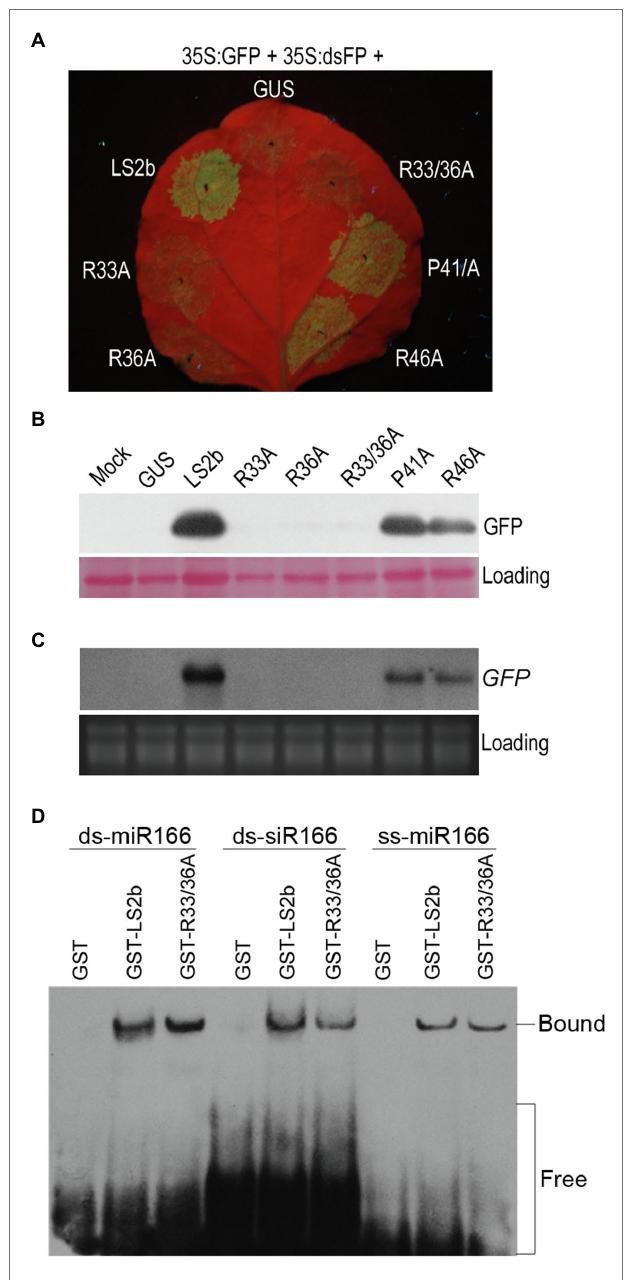
FIGURE 6 | Determination of suppressor activity and sRNA binding ability for LS2b mutants. (A) Observation of GFP fluorescence. The 6th true leaves of N. benthamiana plants were infiltrated with cells of Agrobacterium tumefaciens harboring 35S:GFP and 35S:dsFP, together with cells expressing GUS, LS2b or its mutants as indicated. The mutants are shown in Figure 2A . R33/36A is the mutant that contains two mutations R33A and R36A. The agroinfiltrated leaves were photographed under UV light at 5 days post-infiltration (dpi). (B) Immunoblot analysis of GFP protein accumulation in the patches as shown in (A) . Total proteins were prepared at 5 dpi, and detected by a polyclonal anti-GFP serum. Ponceau S staining was used to monitor the relative amount of total proteins loaded.